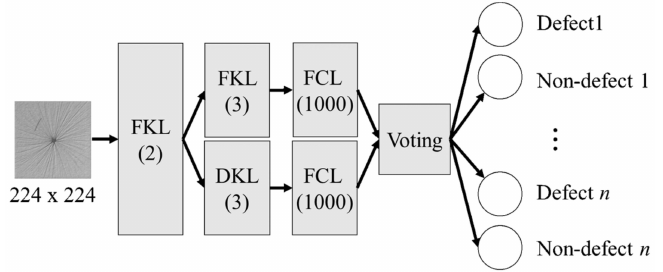
Figure 2. Schematic of the PE-ResNeXt